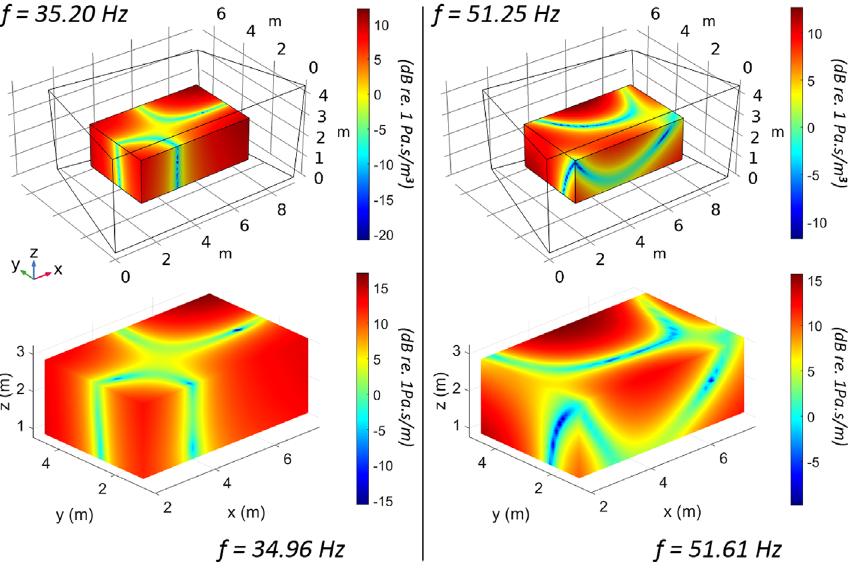
Figure 11. Sound fi eld reconstruction from real measurements (bottom) at two eigenfrequencies (left: near 35 Hz, right: near 51 Hz) as compared to the same eigenmodes from simulations (top).